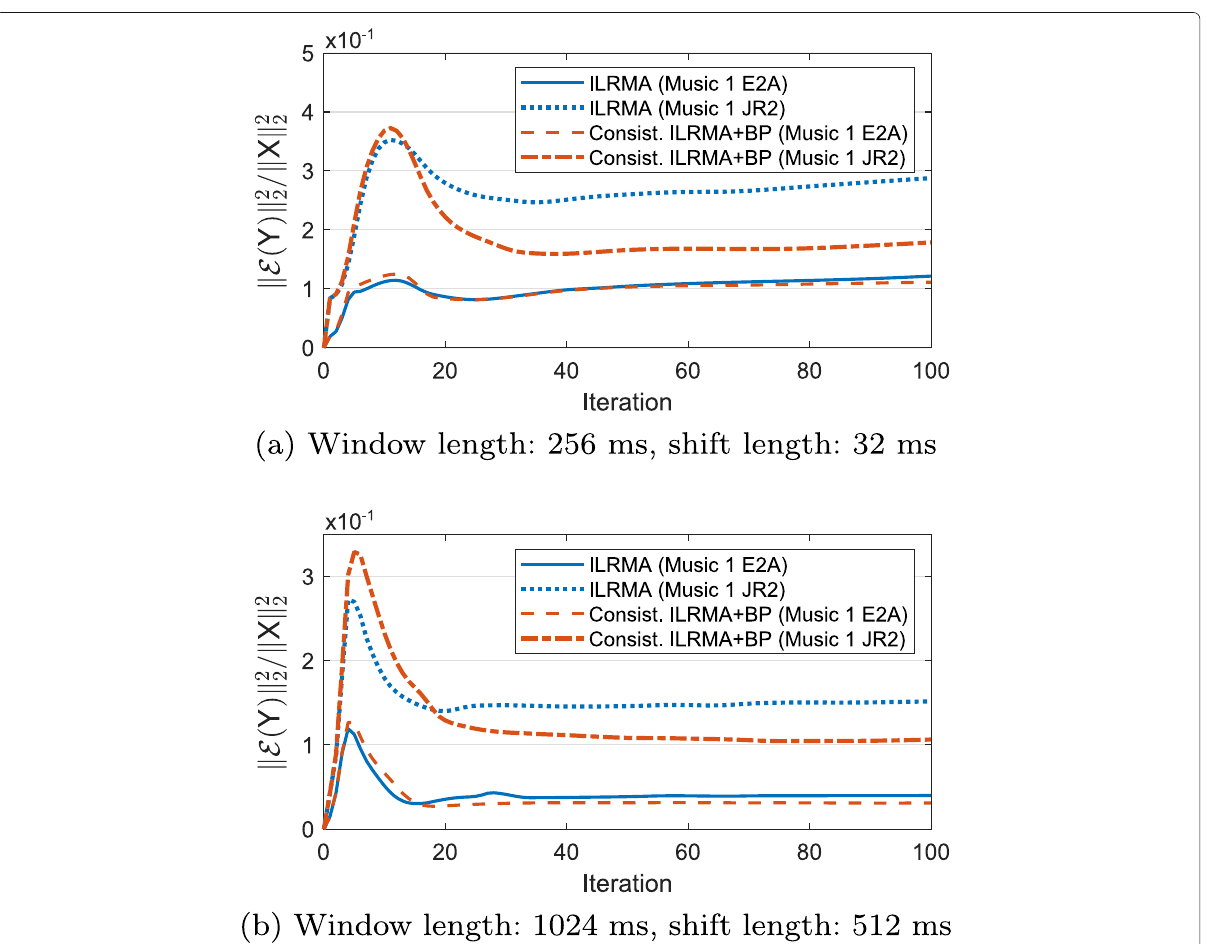
(cid:6) (cid:7) (cid:7) E ( Y ) (cid:7) 2 / (cid:7) X (cid:7) 2 of ILRMA and Consistent ILRMA+BP for music 1: a 256-ms-long 2 2